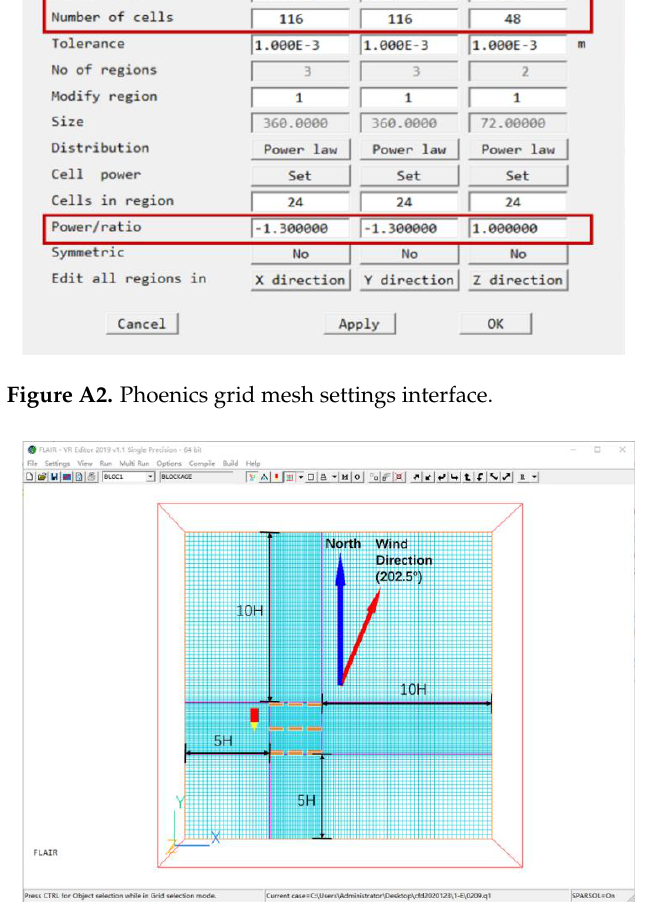
Figure A3. The XY plane grid distribution for seven layout modes (1-E used as the example).